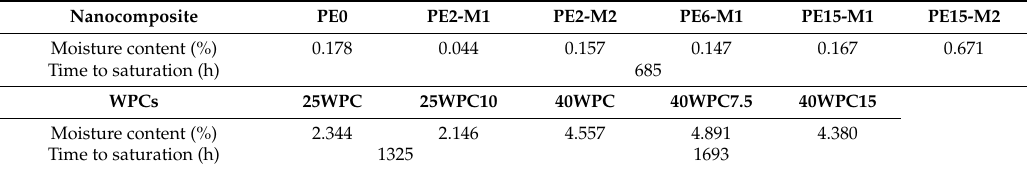
Table 3. Moisture content of conditioned samples in terms of weight percent increase with respect to original dried, sealed samples. Results are the average measurement of three samples conditioned at 40 ◦ C and 99%